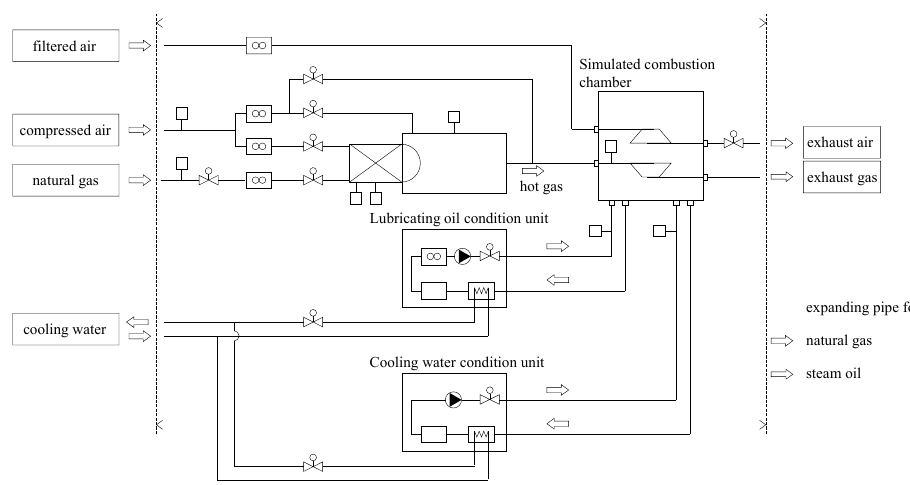
Figure 4. The schematic layout of the coaxial-rotor unit.